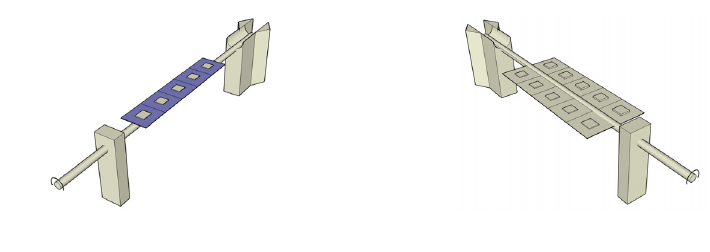
Figure 3. Tilting variants: the axial type (left) and the wing type